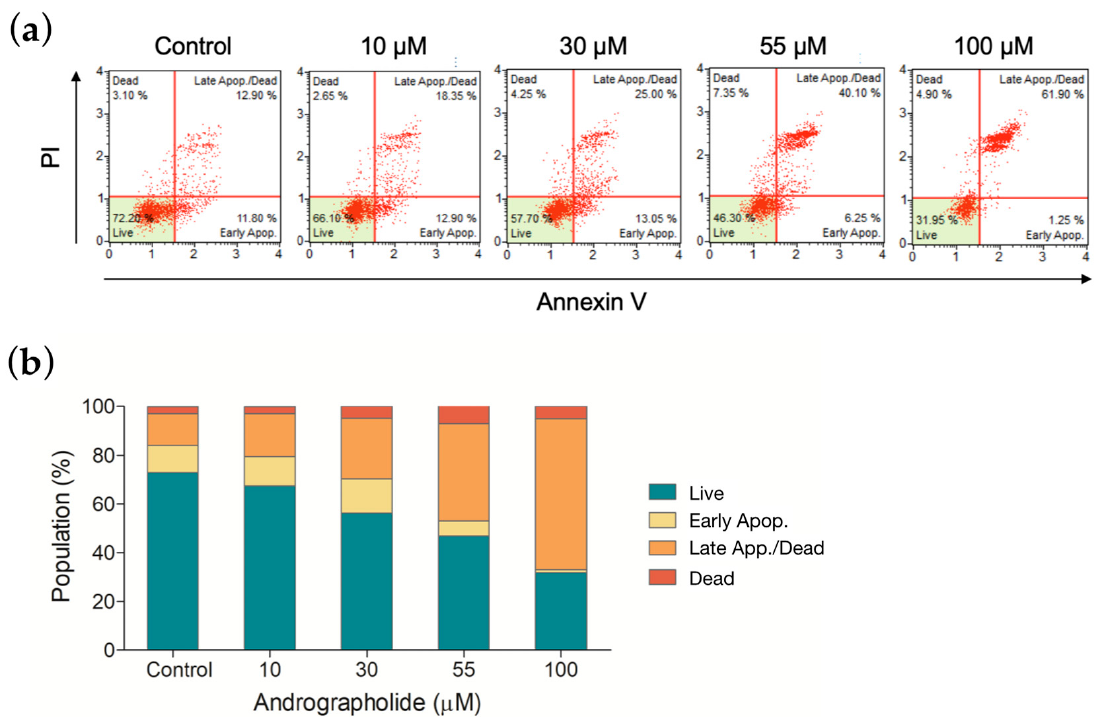
Figure 6. ( a ) Apoptosis was measured by flow cytometry following an annexin V/7 ‐ AAD binding assay. OEC ‐ M1 cells were treated for 24 h using four different concentrations of andrographolide. ( b ) The mortality rate of OEC ‐ M1 cells upon treatments of andrographolide for 24 h at the indicated concentrations.